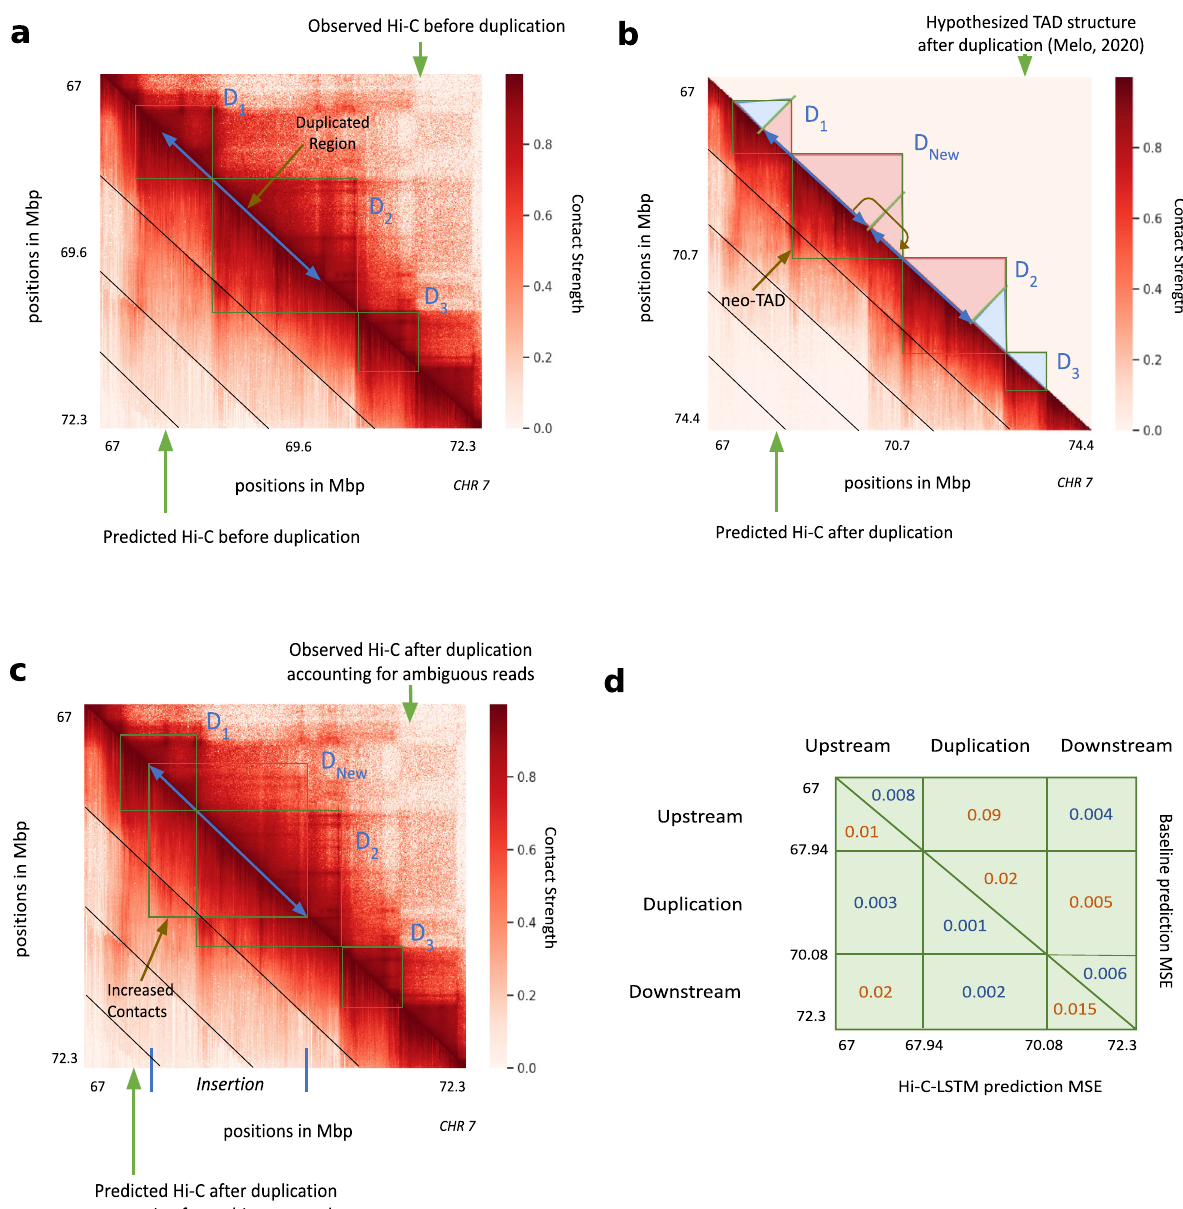
Fig. 7 In-silico duplication of a 2.1 Mbp region on Chromosome 17. In all subplots, upper and lower triangles denote observed and predicted Hi-C contact probabilities respectively, and diagonal black lines denote Hi-C-LSTM frame boundaries. a Observed and predicted Hi-C before duplication. D 1 , D 2 and D 3 indicate the three pre-duplication topological domains. b Predicted Hi-C after duplication on a simulated reference genome that includes both copies. Lower triangle indicates Hi-C-LSTM predicted contacts. The true Hi-C contact matrix on this reference genome is not observable because the read mapper cannot disambiguate between the two copies. The upper triangle depicts the post-duplication topological domain structure hypothesized by Melo et al, which includes a novel topological domain D New . c Observed and predicted Hi-C on the observed pre-duplication reference genome. Upper triangle shows observed post-duplication Hi-C data assayed by Melo et al. Lower triangle shows Hi-C-LSTM predictions, mapped to the pre-duplication reference by summing the contacts for the two copies (see the section “ Results ” ). d Average mean-squared error (MSE) in predicting the observed data by (lower triangle) Hi-C-LSTM, and (upper triangle) a simple baseline (see the section “ Results ” ) at the upstream, duplicated, and downstream